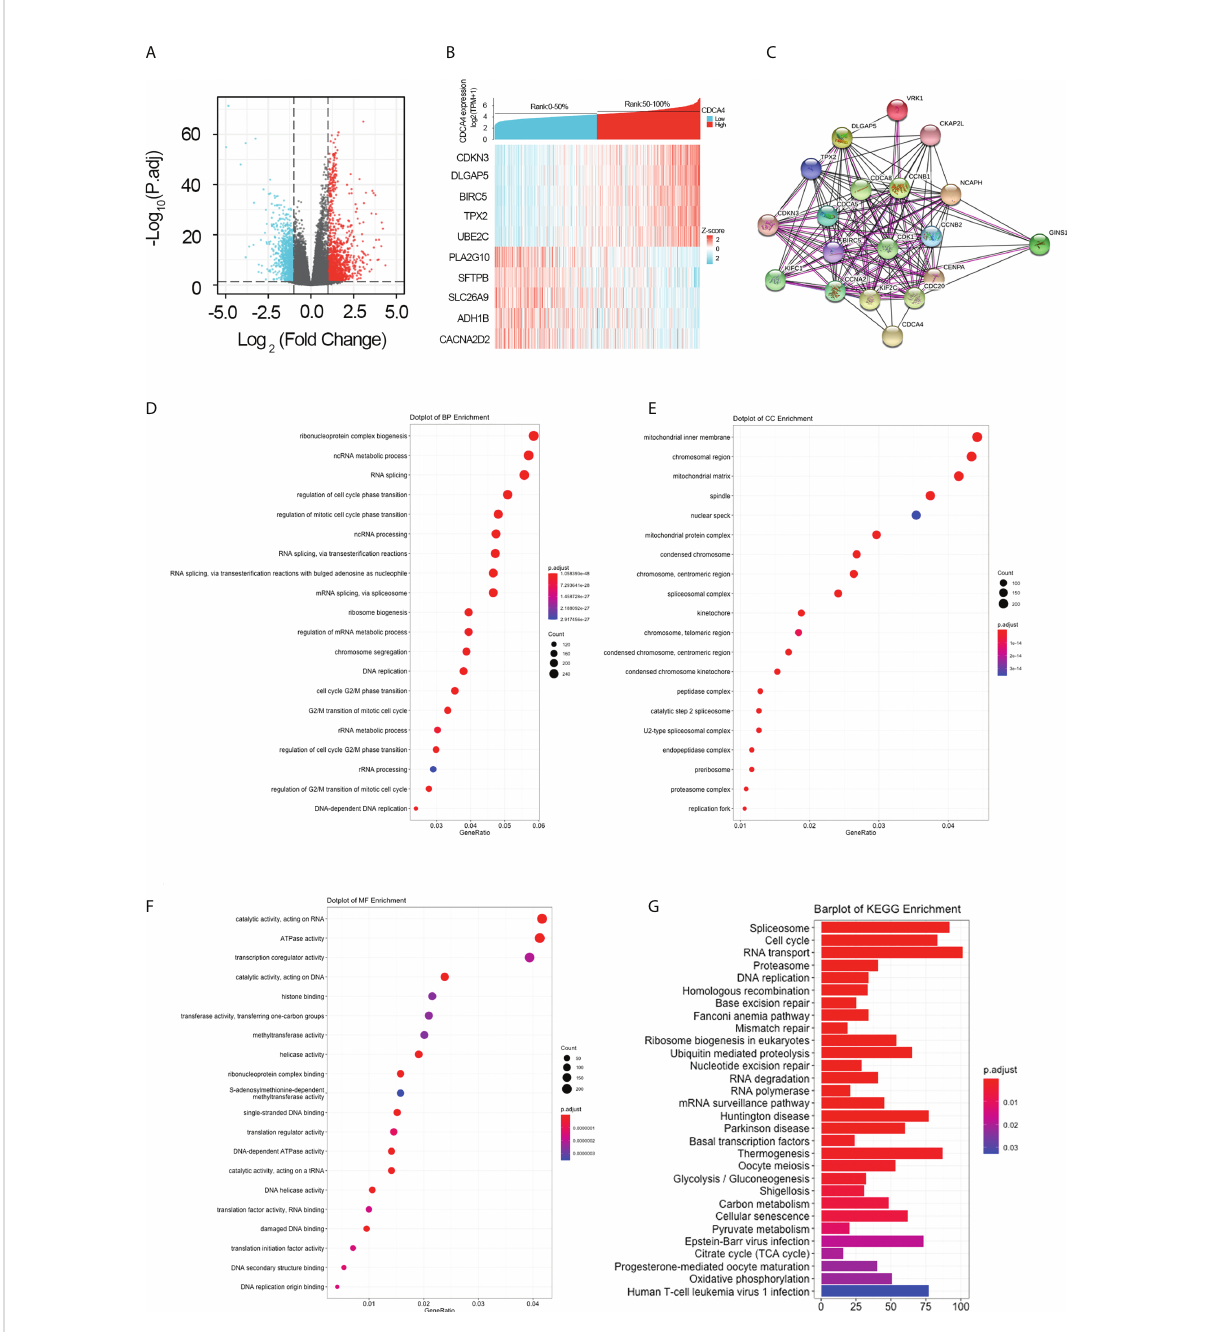
FIGURE 4 Genes co-expressed by CDCA4 and biological functions of CDCA4 associated with LUAD. (A) A volcano plot of differential gene pro fi les between high and low CDCA4 groups shows that 179 genes were up-regulated and 77 were down-regulated (adjusted P -value of 0.01 and | log2-fold change [FC]| > 2). (B) A heat map illustrating the positive co-expression of ten representative CDCA4 genes in LUAD. Data was normalized using the Z-score normalization method. (C) PPI network created and displayed using CDCA4 co-expressed genes from http:// string-db.org. (D) BP outcomes; (E) CC outcomes; (F) MF outcomes from Metascape analysis of functionally enriched GO. (G) . KEGG results based on the expression levels of CDCA4 in the LUAD and TCGA datasets. PPI, protein-protein interaction; KEGG, Kyoto Encyclopedia of Genes and Genomes; BP, biological process; CC, cellular component; MF, molecular